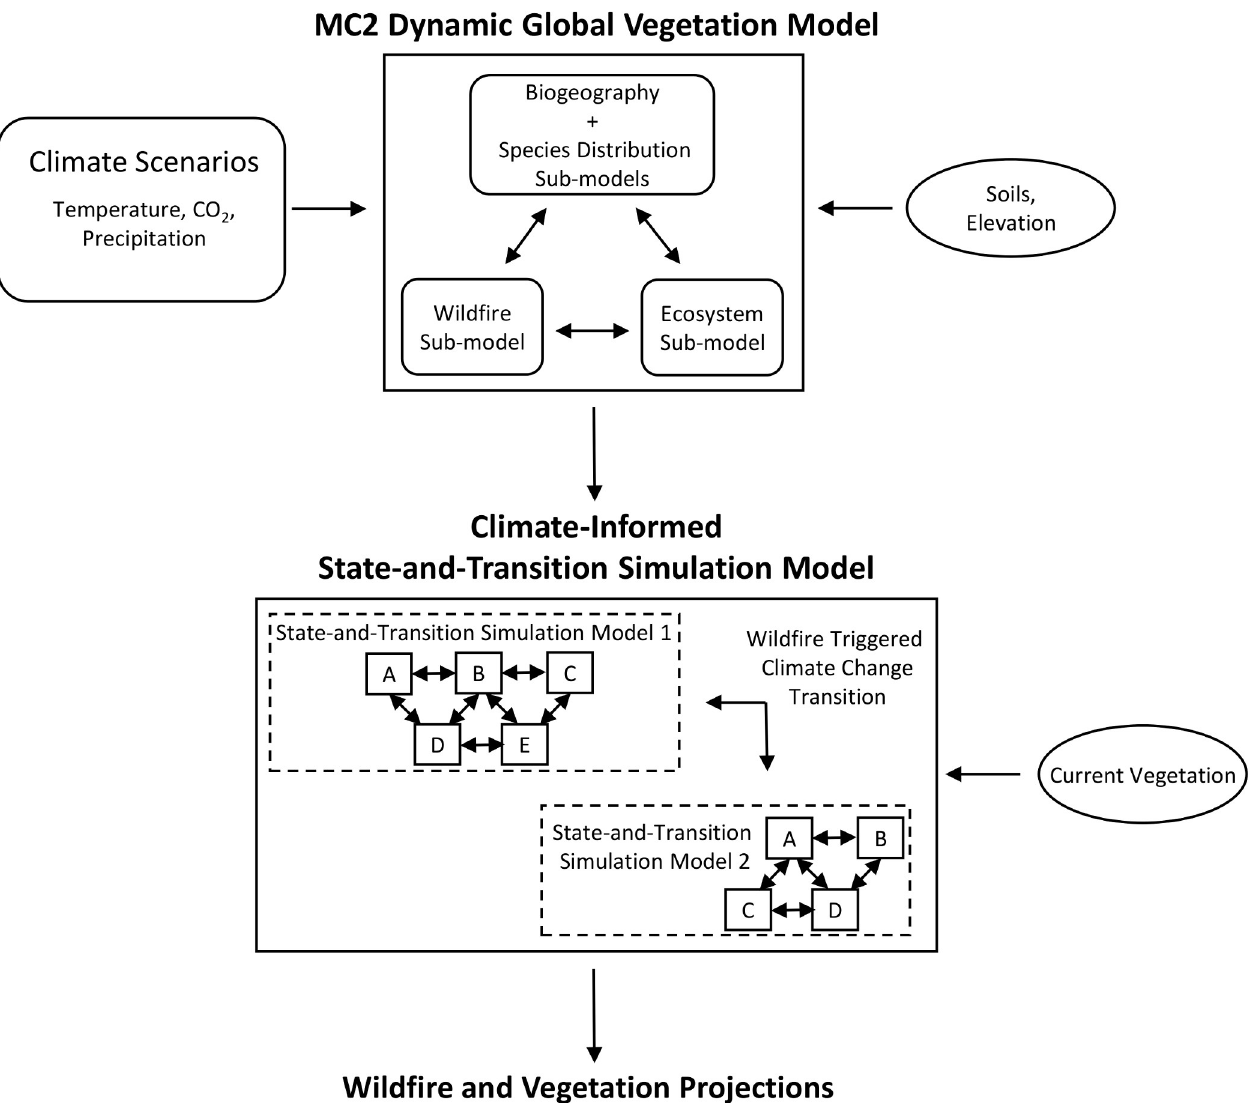
Fig 2. Conceptual overview of modeling process. Ellipses represent model input and rectangles represent models. Unbounded text indicates model outputs. In step1, future climate scenario and biogeographic information are input into the MC2 Dynamic Global Vegetation Model. Within MC2, three sub-models typically interact to project potential future vegetation, wildfire, and carbon, among other output. For this analysis, we included a species distribution model of forest zones within the biogeography sub-model. In step 2, MC2 wildfire and forest zone projections for each climate scenario are analyzed to develop forest transition average probabilities and both wildfire and forest zone trends. In step 3, the MC2-derived trends and probabilities are used to develop climate- informed state-and-transition simulation models (cSTSMs) for each climate scenario. Within a cSTSM, area is permitted to shift across previously developed state-and-transition simulation models (two simplified example models are shown) following a stand-replacing disturbance (i.e., when landscape inertia is broken). Figure adapted from [46]. https://doi.org/10.1371/journal.pone.0209490.g002 characteristics (1-h, 10-h, 100-h, and 1000-h fuels derived from the biogeography model), to simulate the initiation and behavior of a wildfire event. Fire events are initiated when region- specific fuel buildup thresholds are exceeded and fine fuel moisture drops below region- defined thresholds. Sources of ignition are assumed to always be available. Fire spread is not spatially explicit between 800-m simulation cells. Rather, the number of years since the last fire event divided by forest zone fire rotations are used to estimate the fraction of a cell annually burned.